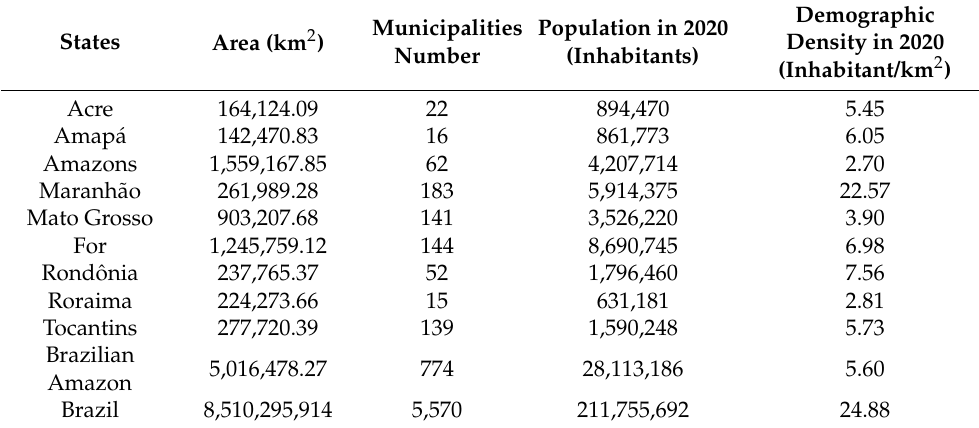
Table 12. Area, population, and municipalities number in Brazilian Amazon. Source: [21]. Municipalities States Area (km 2 ) Number